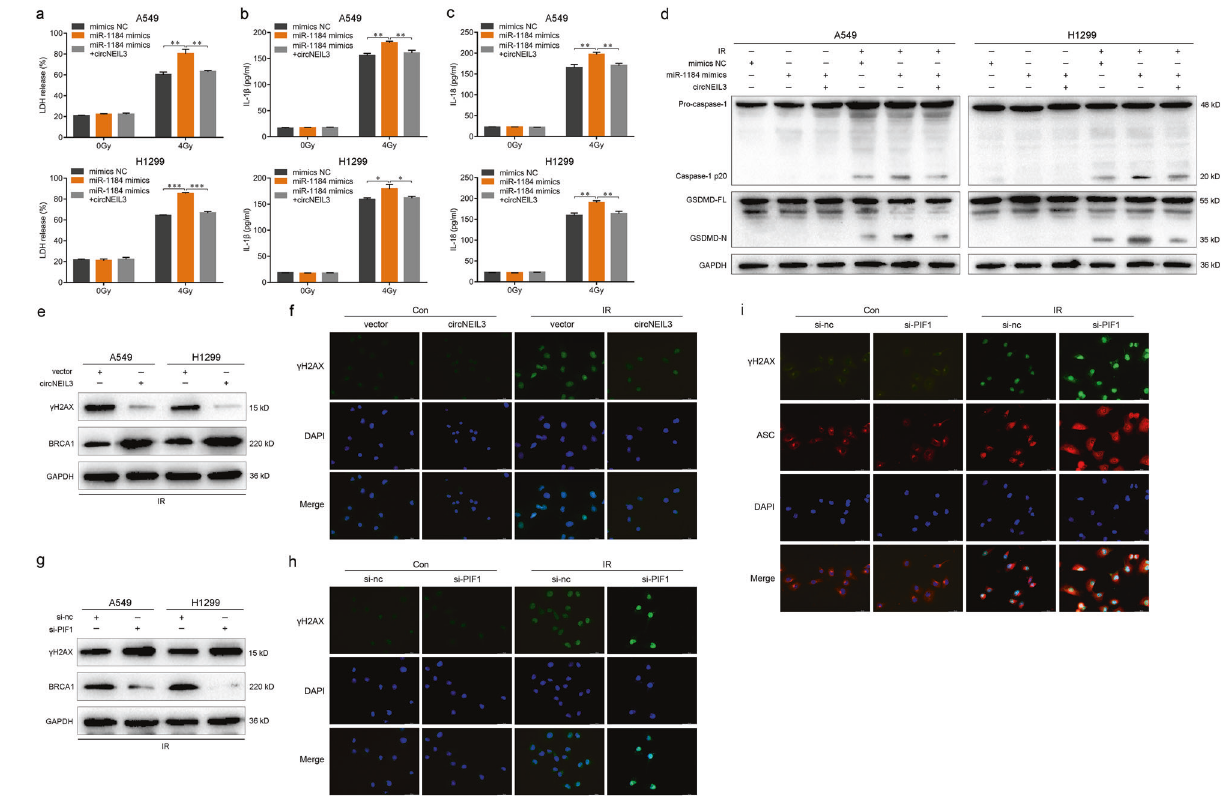
Fig. 6 The circNEIL3/miR-1184/PIF1 axis mediates pyroptosis via the DNA damage repair pathway. a – c Enzyme-linked immunosorbent assays detecting the release of LDH, IL-1 β , and IL-18 in LUAD cells transfected with miR-1184 mimics alone or co-transfected with circNEIL3. d Western blot of the expression of active-caspase-1 and GSDMD-N in the indicated groups. e Expression levels of γ H2AX and BRCA1 in irradiated LUAD cells with circNEIL3 overexpression. f Immuno fl uorescence staining of γ H2AX in A549 cells with or without circNEIL3 overexpression. g Expression levels of γ H2AX and BRCA1 in irradiated LUAD cells with PIF1 knockdown. h Immuno fl uorescence staining of γ H2AX in A549 cells treated with si-nc or si-PIF1. i Immuno fl uorescence co-staining of γ H2AX and ASC in A549 cells treated with si-nc or